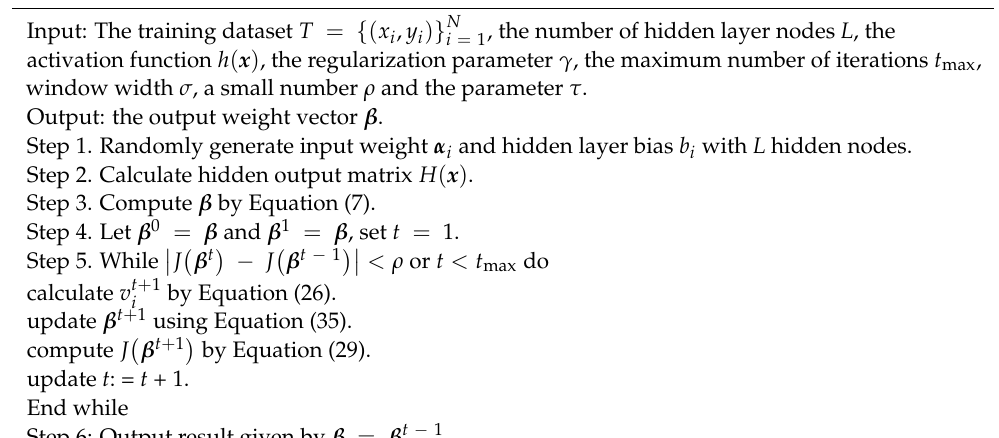
Algorithm 1. Half-quadratic optimization for L 1